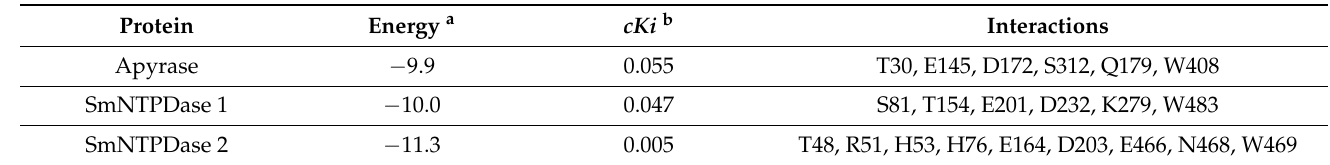
Table 2. Molecular docking results for NTPDases target proteins. The energy and cKi values as well as interactions represent the asiaticoside pose with best protein contacts.